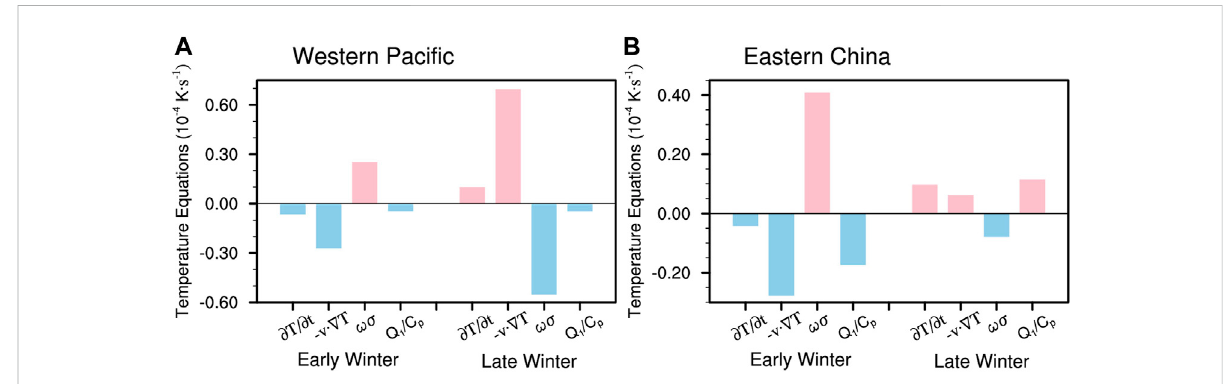
FIGURE 10 Regional averages of vertical integral difference in each contribution of the temperature tendency equations (shading; units: 10 − 4 K s − 1 ) between P2 and P1 in early and late winters at 1000 – 850 hPa over (A) western Paci fi c (20 – 40 ° N, 120 – 150 ° E) and (B) east